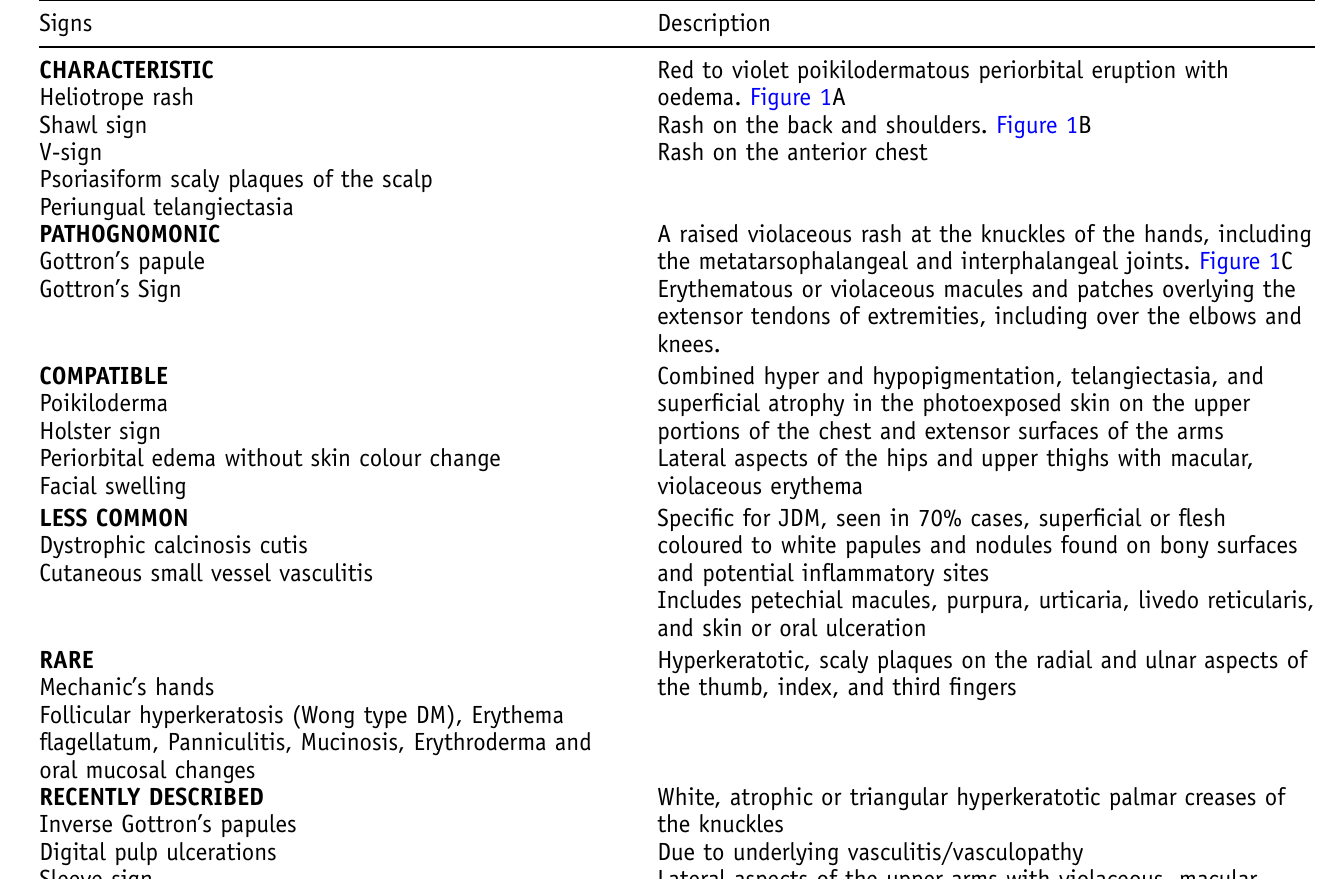
Table I. Cutaneous manifestations of dermatomyositis.